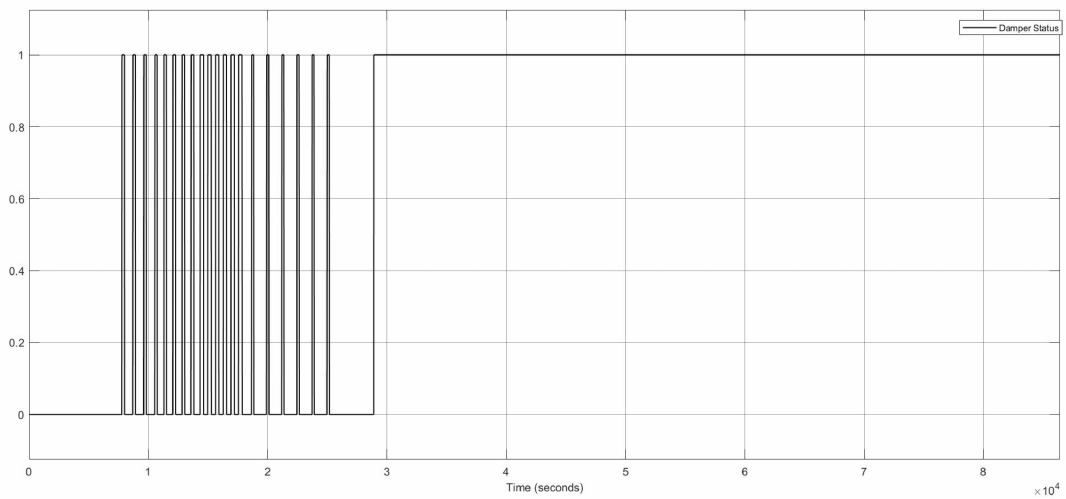
Figure 11. Damper actuator statuses for the heater actuator and CO 2 sensor